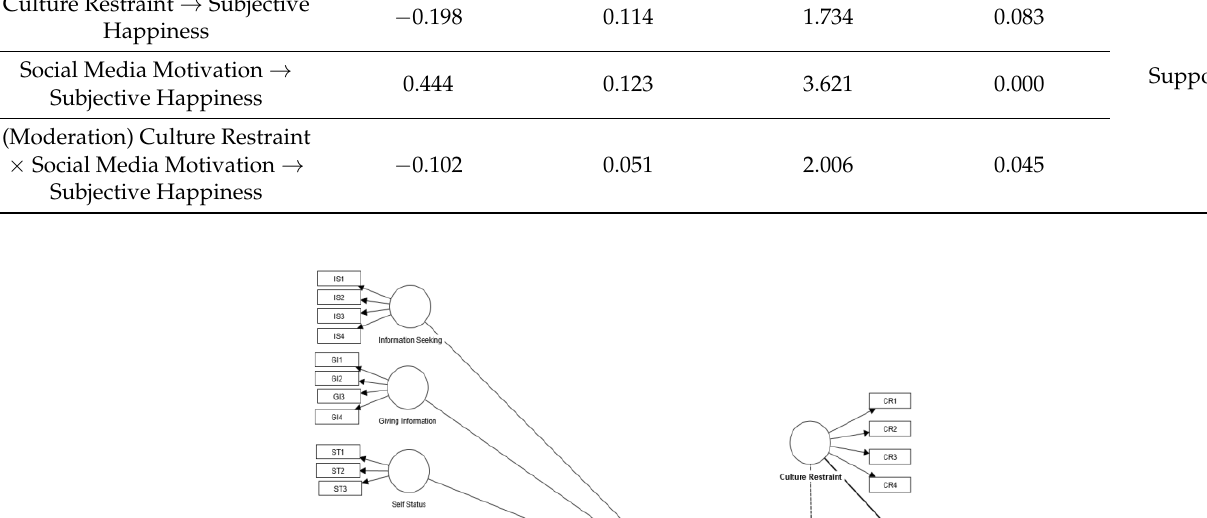
Table 6. The moderation analysis.